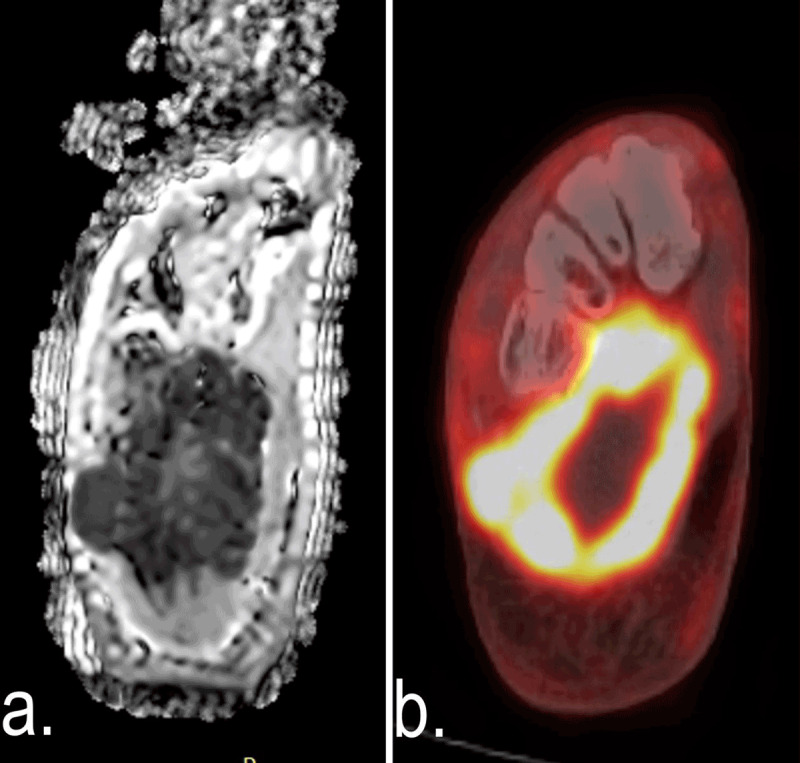
DWI (a) and FDG-PET/CT (b) images of a 35-year-old male with a soft tissue mass in the right foot. ADCmean, ADCmin and SUVmax of the lesion were 0.55 × 10–3mm2/s, 0.31 × 10–3mm2/s and 24.31, respectively. The lesion was diagnosed as undifferentiated pleomorphic sarcoma after core needle biopsy.